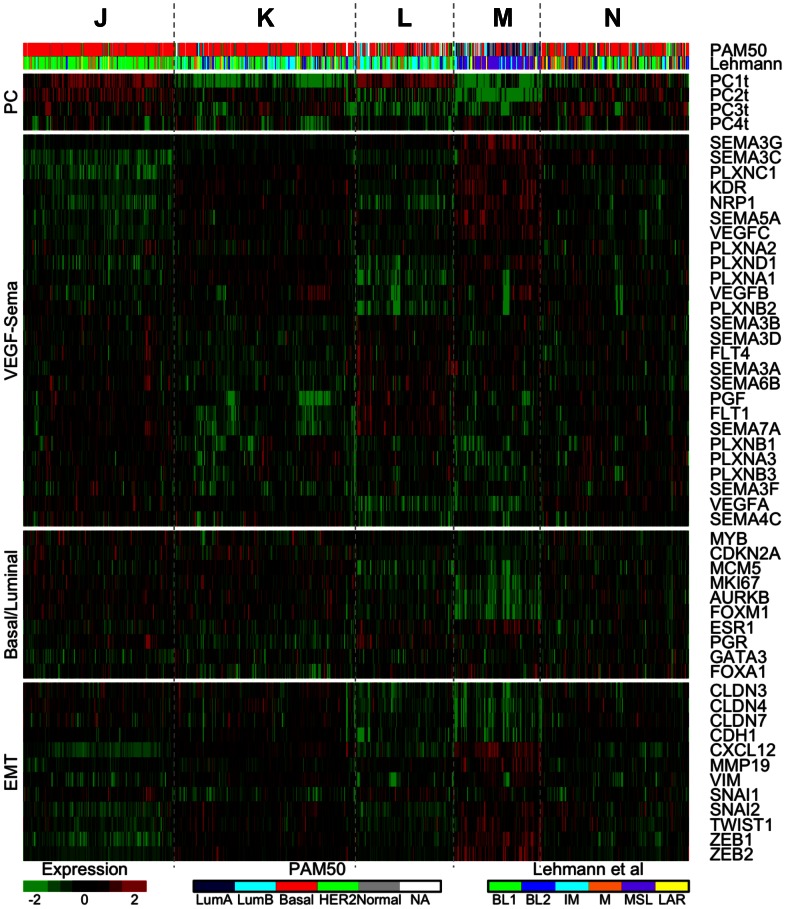
Heatmap of the 5 VEGF/Sema-based TNBC clusters.Consensus K-means clusters of only the TNBC data are arranged according to the ordering from Figure 4, in that the TNBCs that appeared in tumor cluster A generally now appear in TNBC cluster J (although the correspondence is not perfect) and so on for the other clusters. The VEGF/Sema-based clusters are able to differentiate the MSL subtype from Lehmann et al. (cluster M) from the other TNBC subtypes. Claudin-low subtype-related patterns of gene expression in the panel labeled “EMT” were associated with cluster M, the MSL-enriched cluster.